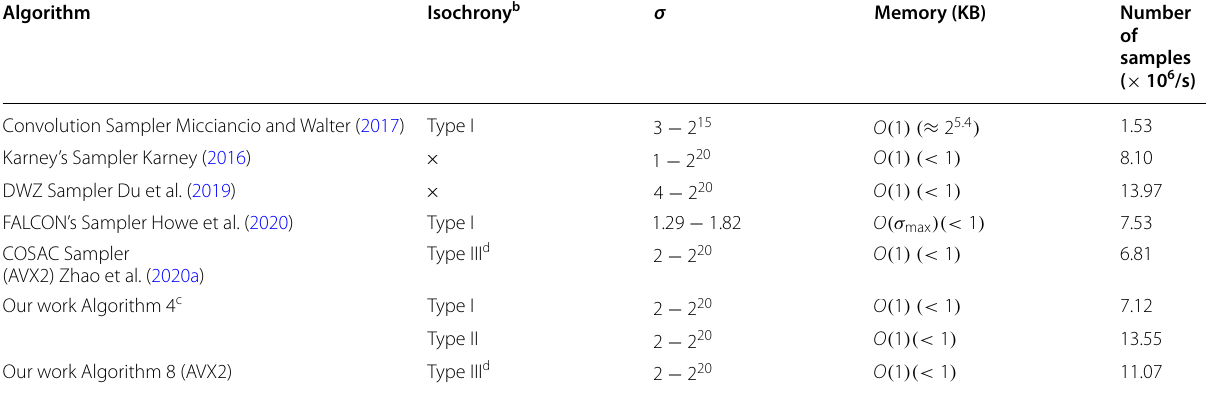
Table 1 Comparison between our work and existing generic a samplers at 3.6